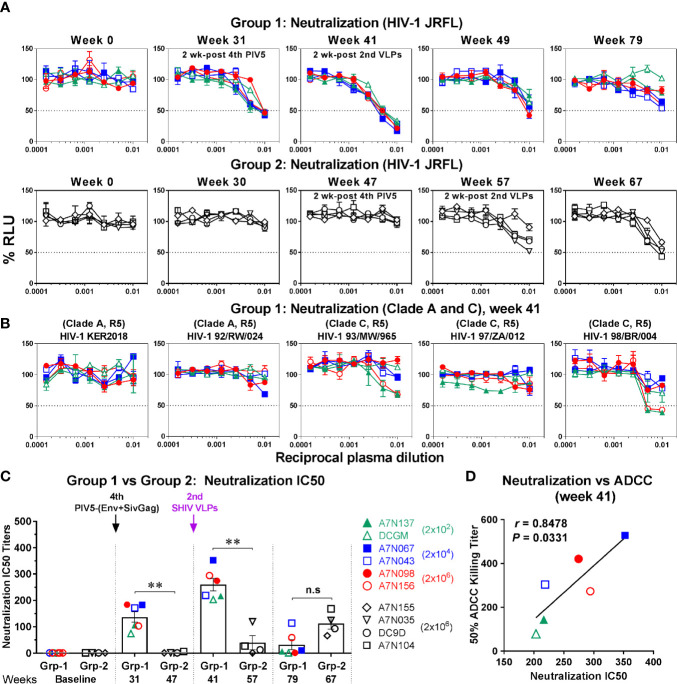
Neutralization against HIV-1. (A) Plasma samples in Group 1 (upper panel) and Group 2 (lower panel) were incubated with HIV-1 JRFL and tested for the ability to block viral infectivity (as the dose-dependent loss of luciferase activity in RLU) using the TZM-bl neutralization assay. The dotted line indicates half-maximal infection or 50% neutralization (IC50). (B) Neutralization against the indicated HIV-1 viruses (clade A or C, tier 2) was measured in Group 1 (week 41). (C) Comparison of neutralization IC50 titers between Group 1 (Grp-1) and Group 2 (Grp-2) at the indicated time points receiving the same immunization, respectively (solid arrows). Error bars indicate the standard errors of the means. Each dot represents an individual animal. Statistical analyses were considered significant of P values as follows: *P < 0.05; **P < 0.01. n.s, P > 0.05, not significant. (D) Correlation between neutralization and ADCC activity against HIV-1 JRFL in Group 1 (week 41). The correlation coefficients (r) and P values were derived from Spearman rank analysis.